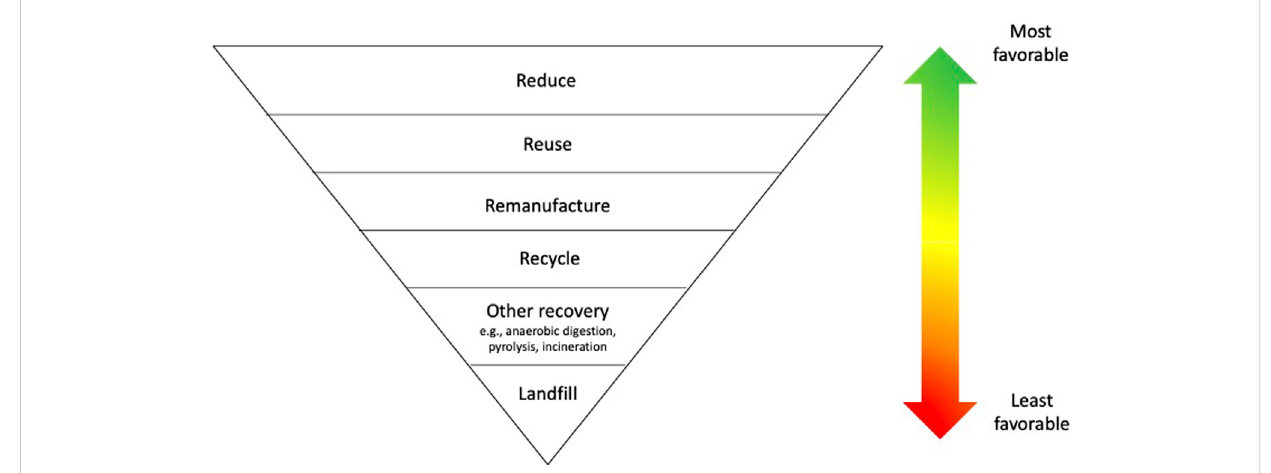
The waste hierarchy (Adapted from the EU Waste Framework Directive 2008/98/EC & Mathur et al., 2019).